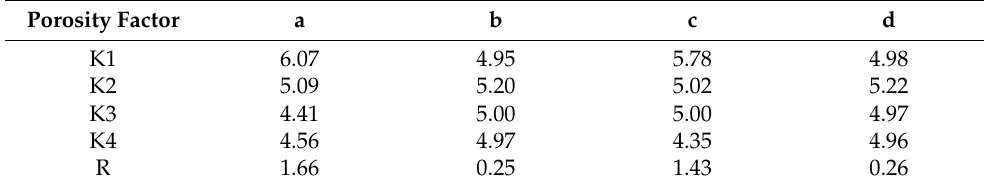
Table 14. Porosity-range